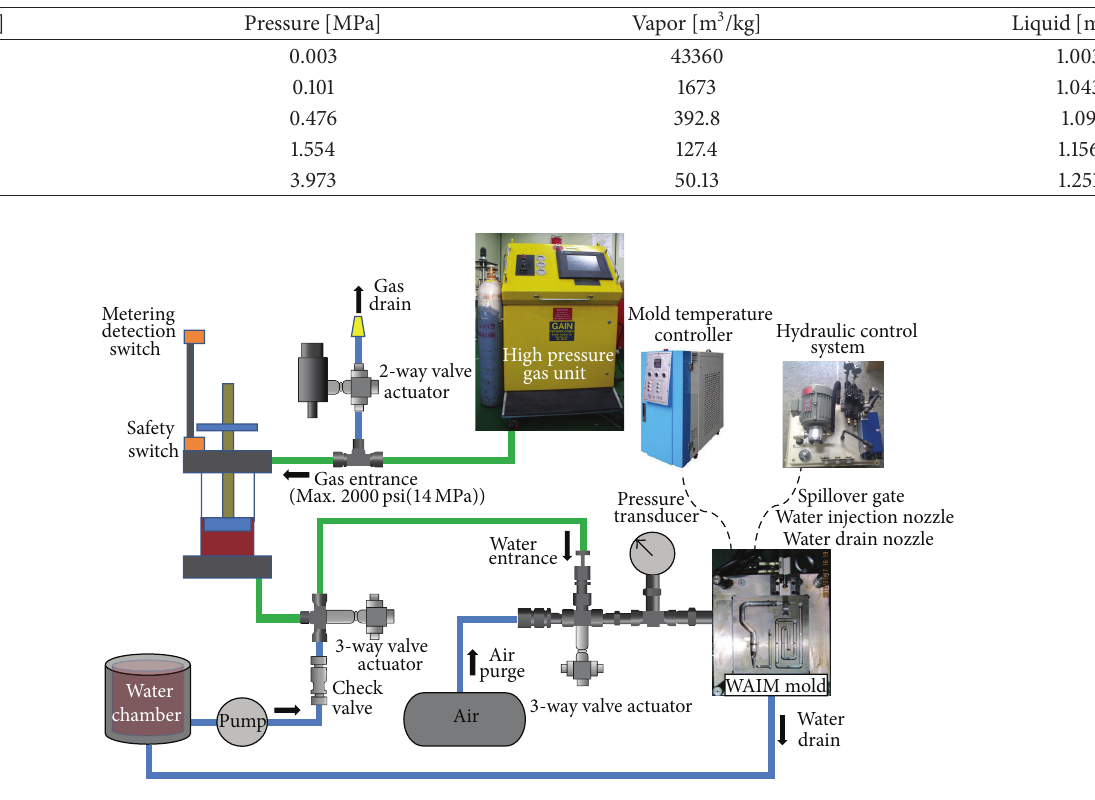
Figure 5: Schematic of the GAIM-based WAIM system for experiment.